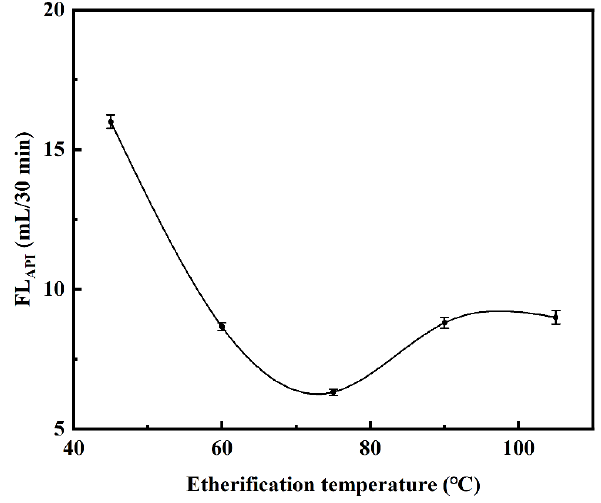
Figure 8. Effect of etherification temperature on saturated NaCl brine base slurry filtration loss performance of CMCS. (The mass ratio of m NaOH :m MCA :m PPS was 1:1:2).